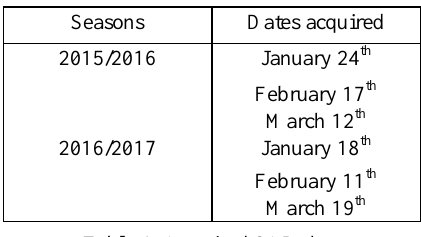
Table 1: Acquired SAR